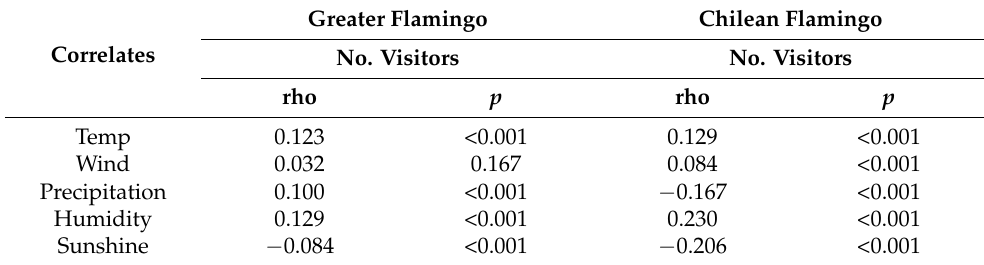
Figure 4. Correlation between the counts of key behaviours performed by the greater flamingo flock during zoo-reopen condiiton and enviornmental factors. Number of visitors did not corre- late with behaviour. Shaded areas around lines represent ± 95% CI. Weak signifcant correlations (0.1 ≤ r s ≤ 0.29) were held between: temperature-inactivity, unknown; wind-inactivty, vigialnce, and unknown; precipitation-feeding, movement, vigilance, and unknown; humidity-preening and inactivity; sunshine-preening, inactivity, movement, vigilance, and unknown. A significant moderate correlation (0.3 ≤ r s ≤ 0.49) was shown between precipitation and inactivity. Table 3. Spearman’s rank correlation outputs testing association between climatic variables and the number of visitors within the Greater and Chilean Flamingo enclosure during zoo re-open